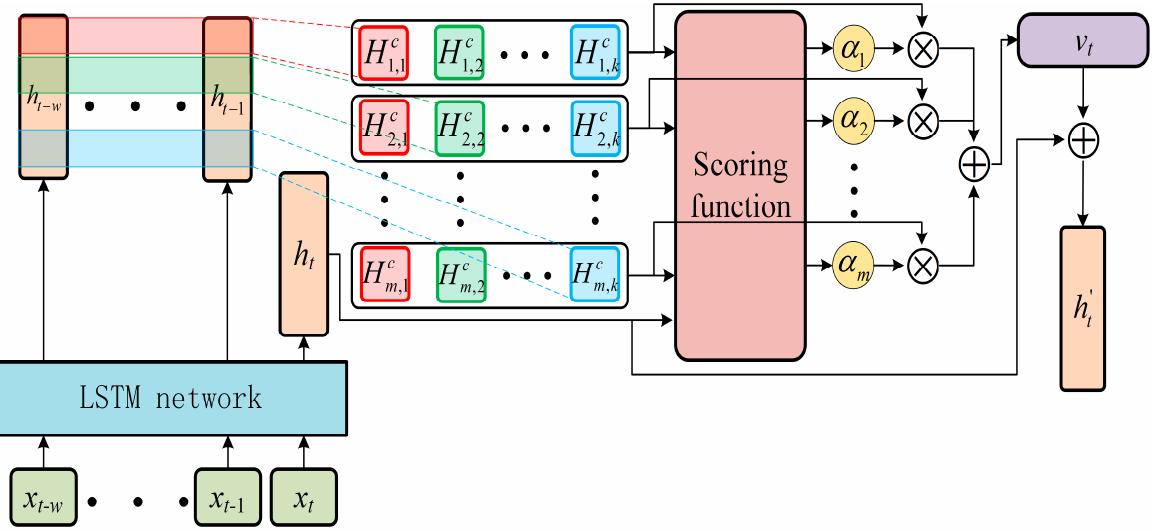
Figure 5. Schematic diagram of the TPA–LSTM.